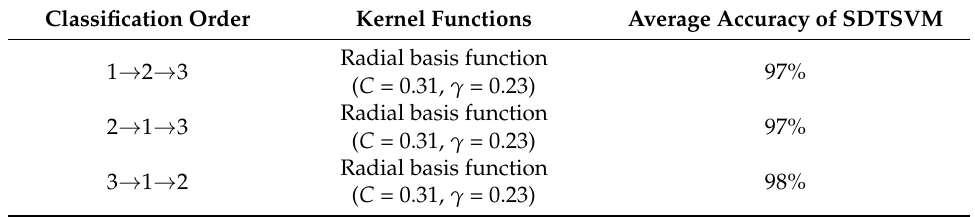
Table 3. Classification results of the Wine data sets for the three classification orders using the SDTSVM algorithm with a radial basis function and a five-fold cross-validation.